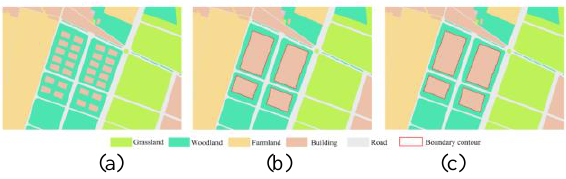
Figure 10. Comparison of aggregation results for the simple grid pattern. (a) Original data; (b) result of mixed integer programming; and (c) result of the method proposed in this paper.